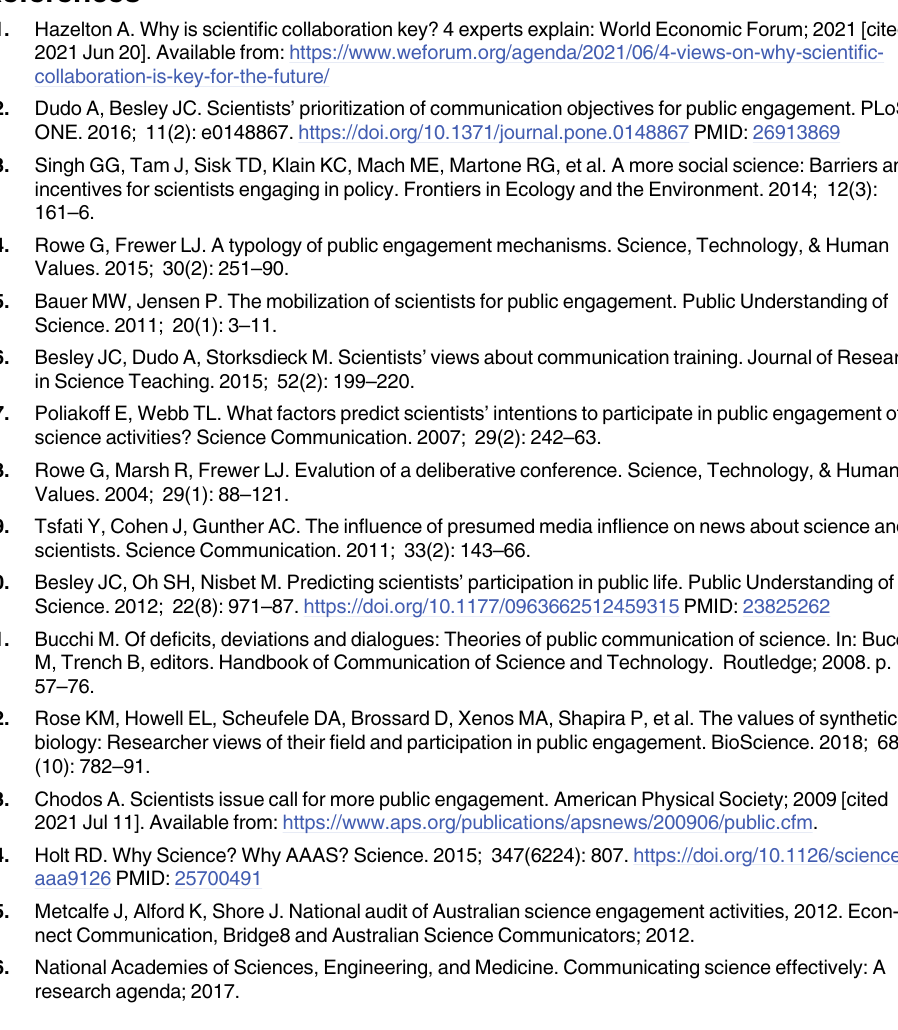
S2 Table. Zero-order correlations of all